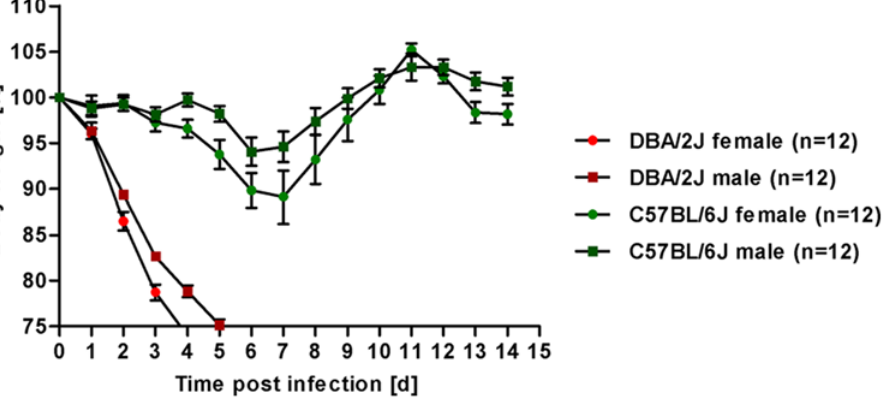
Figure 4. Male and female mice of DBA/2J and C57BL/6J mice show similar weight loss and survival after infection with Influenza A virus. DBA/2J female, DBA/2J male, C57BL/6J female and C57BL/J male were infected intra-nasally with 2 6 10 3 FFU PR8 virus. Weight loss and survival of infected mice was followed over a period of 14 days. Mortality includes also mice that were sacrificed because they had lost more than 25% of body weight. Mean percent of body weight change ( 6 SEM) is shown. p-values for significance were calculated for pair wise comparison between all groups and for all days using non-parametric Mann-Whitney-U-test. On days 2–4, all DBA/2J male and female groups differed significantly in their weight loss from the C57BL/6J groups (p , 0.001 for all comparisons). No consistently significant difference was observed between male and female C57BL/6J groups (except at day 4, p , 0.05), whereas the male and female DBA/2J groups were significantly different at days 2–4 (p , 0.05 at day 2 and p , 0.01 at days 3,